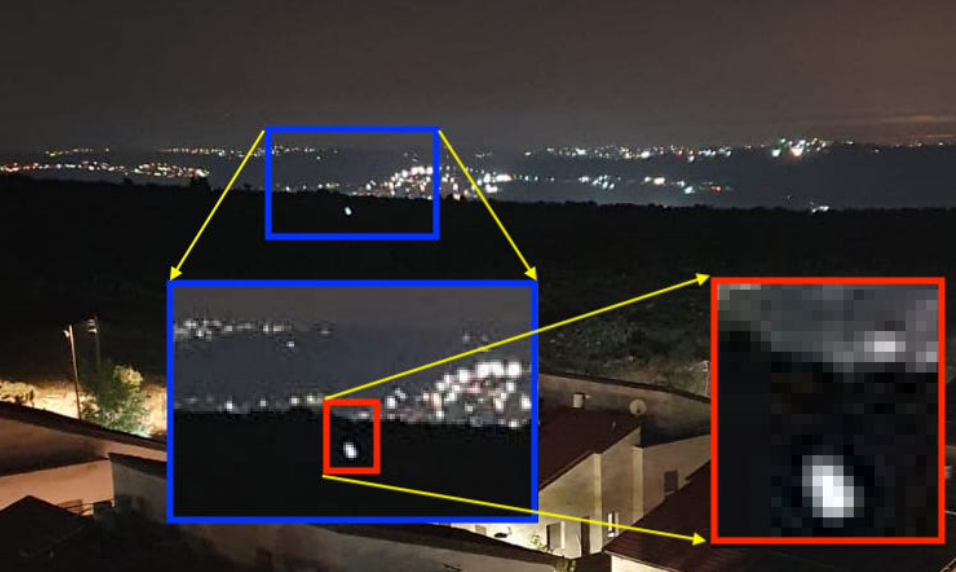
Figure 9. The LED array of SATLLA-2 (Eng-model) as seen from 1.1 km. The image was taken with a standard 70-degree smartphone camera—shooting at 30 fps in 1080p video format. It should be noted that in low-light-pollution conditions (on clear nights), SATLLA2 can be detected from more than 10 km using a standard Raspberry Pi V3 camera (FoV = 80, Sony